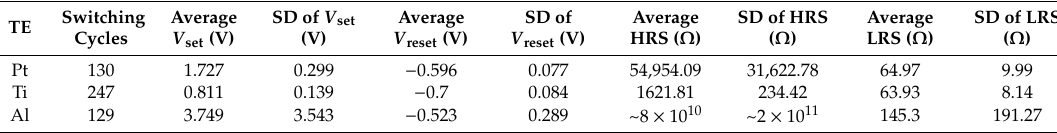
Figure 6. Endurance test of the IGO RRAM with different TEs: ( a ) resistance versus cycles; ( b ) voltage versus cycles; ( c ) retention test of the IGO RRAM with different TEs. Table 1. Some parameters of IGO RRAM with TE of Pt, Ti, and